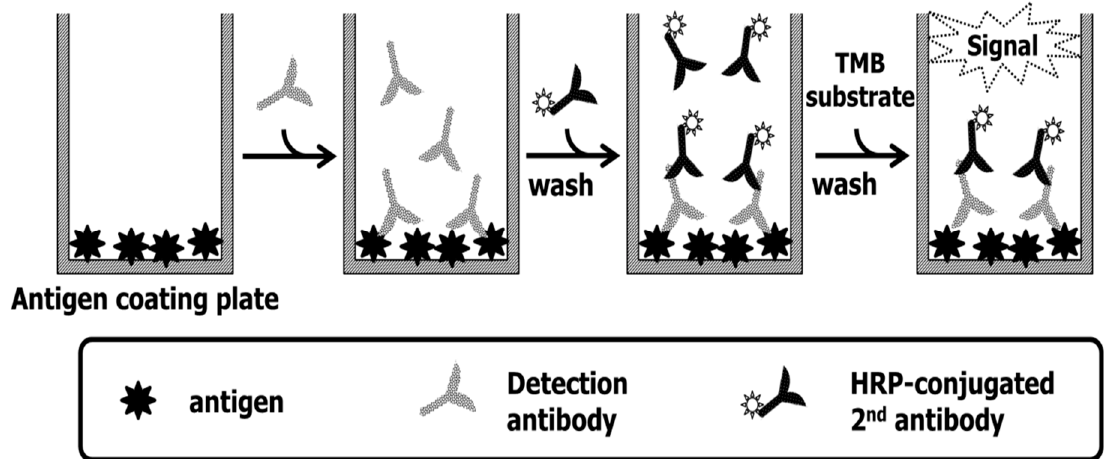
Figure 7. Schematic of indirect ELISA. The antigens were Fbg, Fbg Frag E, and Fbg Frag D. The detection antibodies were pAb and mAb.